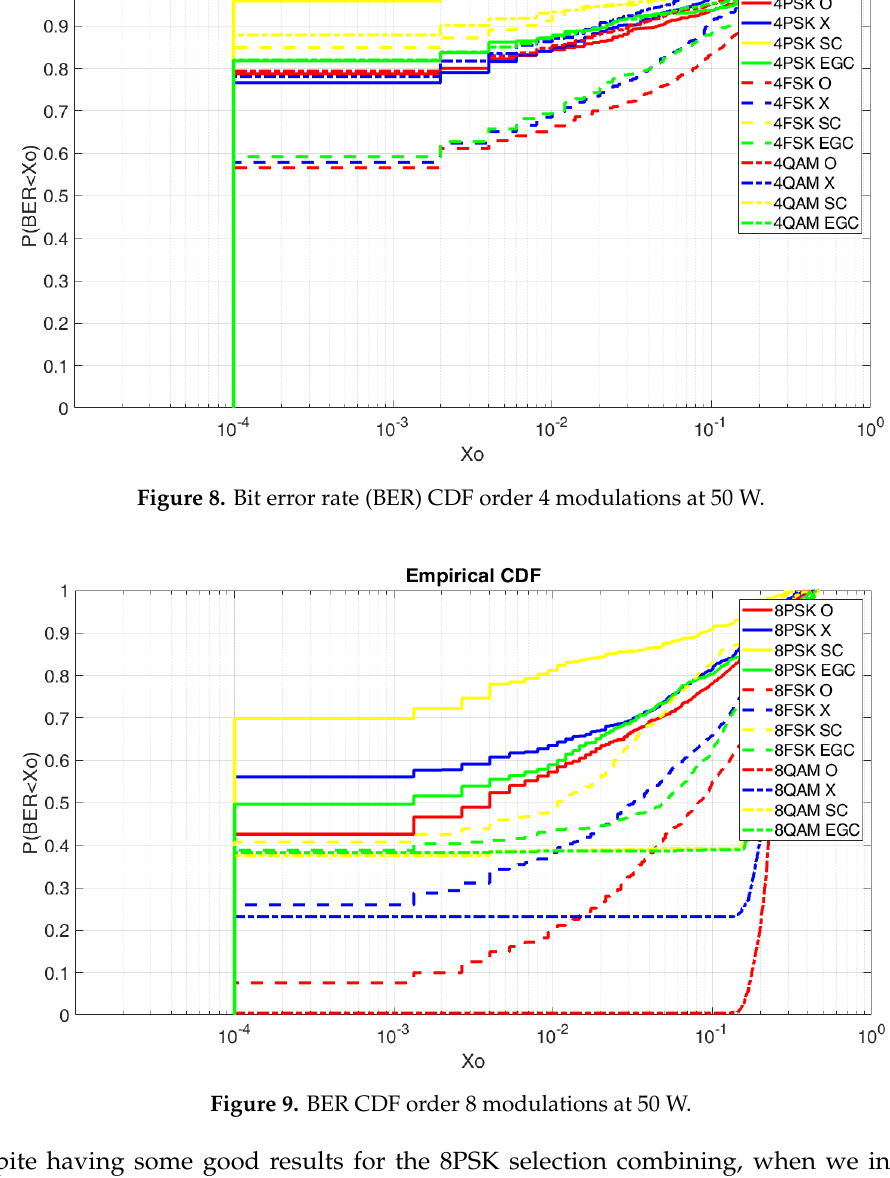
Figure 8. Bit error rate (BER) CDF order 4 modulations at 50 W.